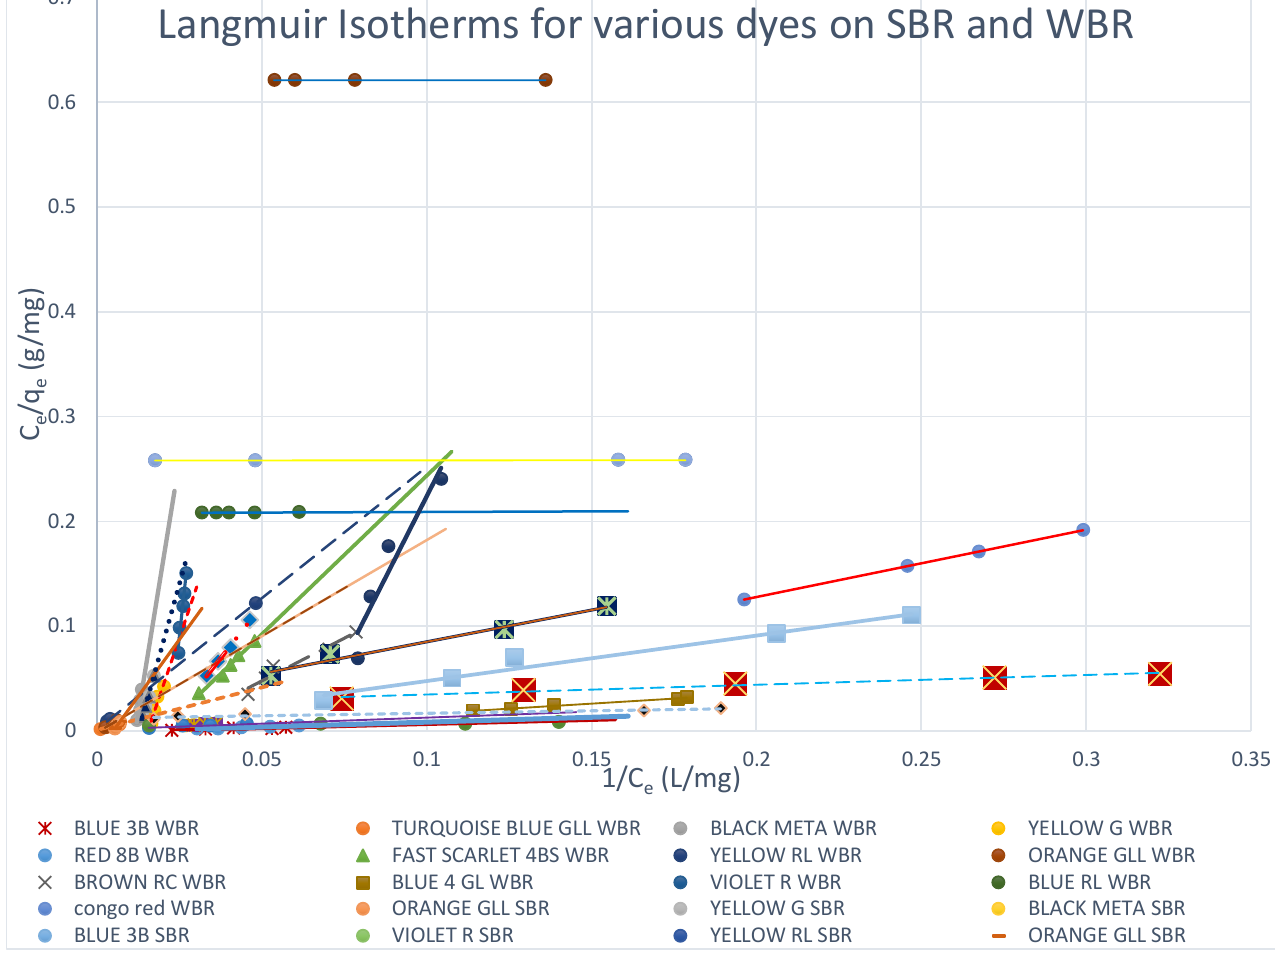
Figure 15. Langmuir isotherms for various dyes on SBR and WBR. Table 7. Equations, values of slope, and intercept for Langmuir isotherms.